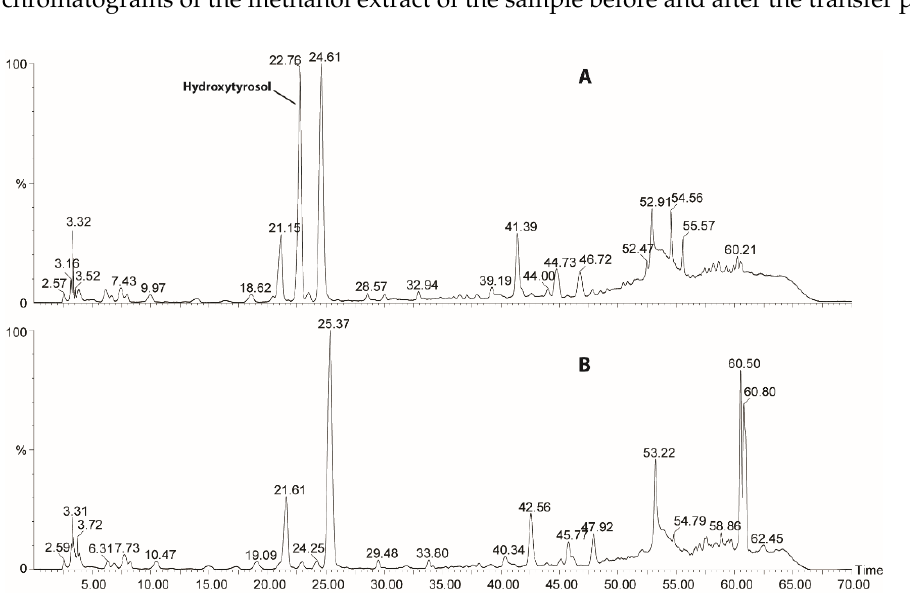
Figure 1. HPLC ‐ UV chromatograms at λ = 280 of the methanolic extract of the flour ( A ) after the SFE experiments and ( B ) before the procedure.